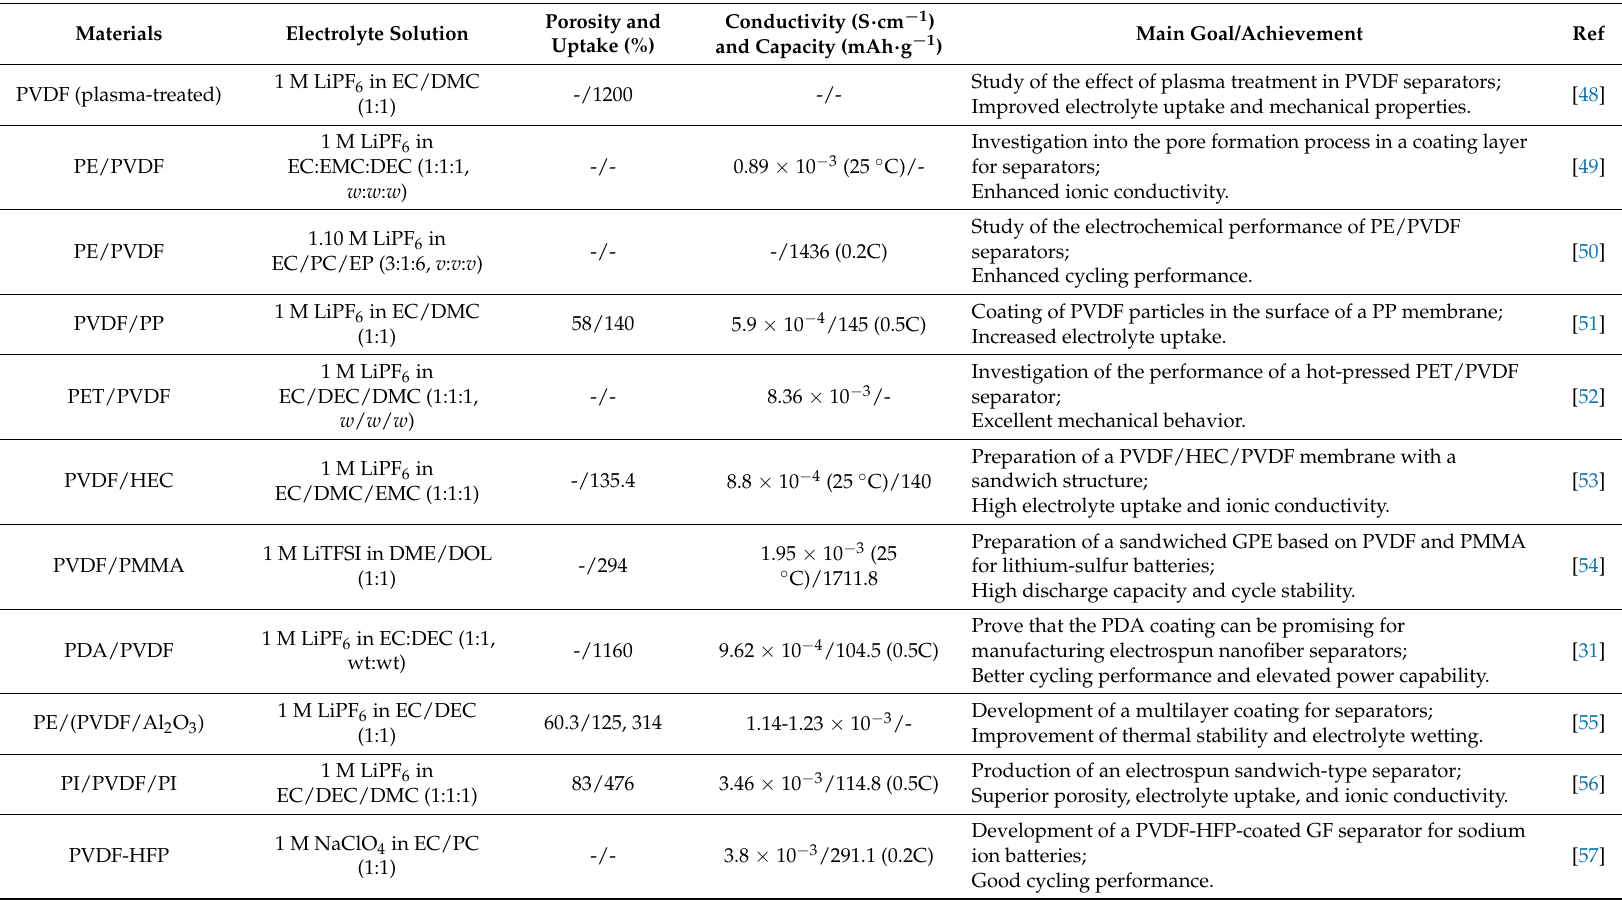
Table 4. Surface modifications on PVDF and co-polymers, indicating also the main properties, goal and